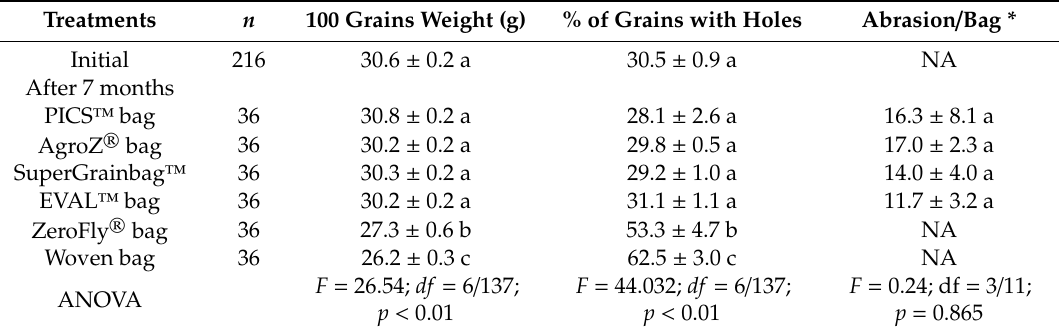
Table 5. Grain damage and weight of naturally infested maize as well as number of abrasions on liner of hermetic bags after seven months of storage in Parakou,